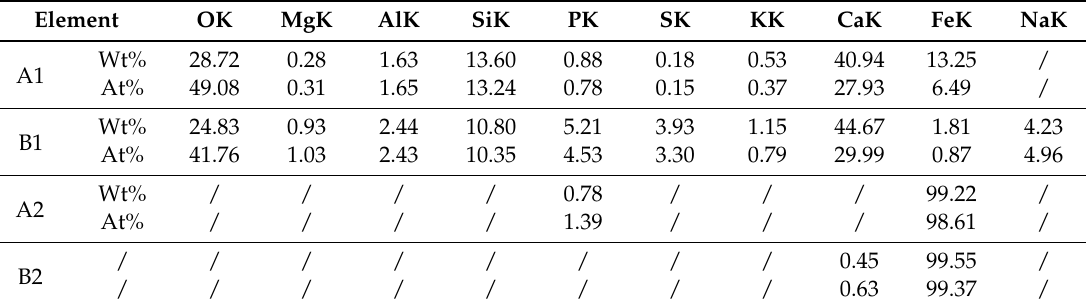
Table 8. Element content of different points in